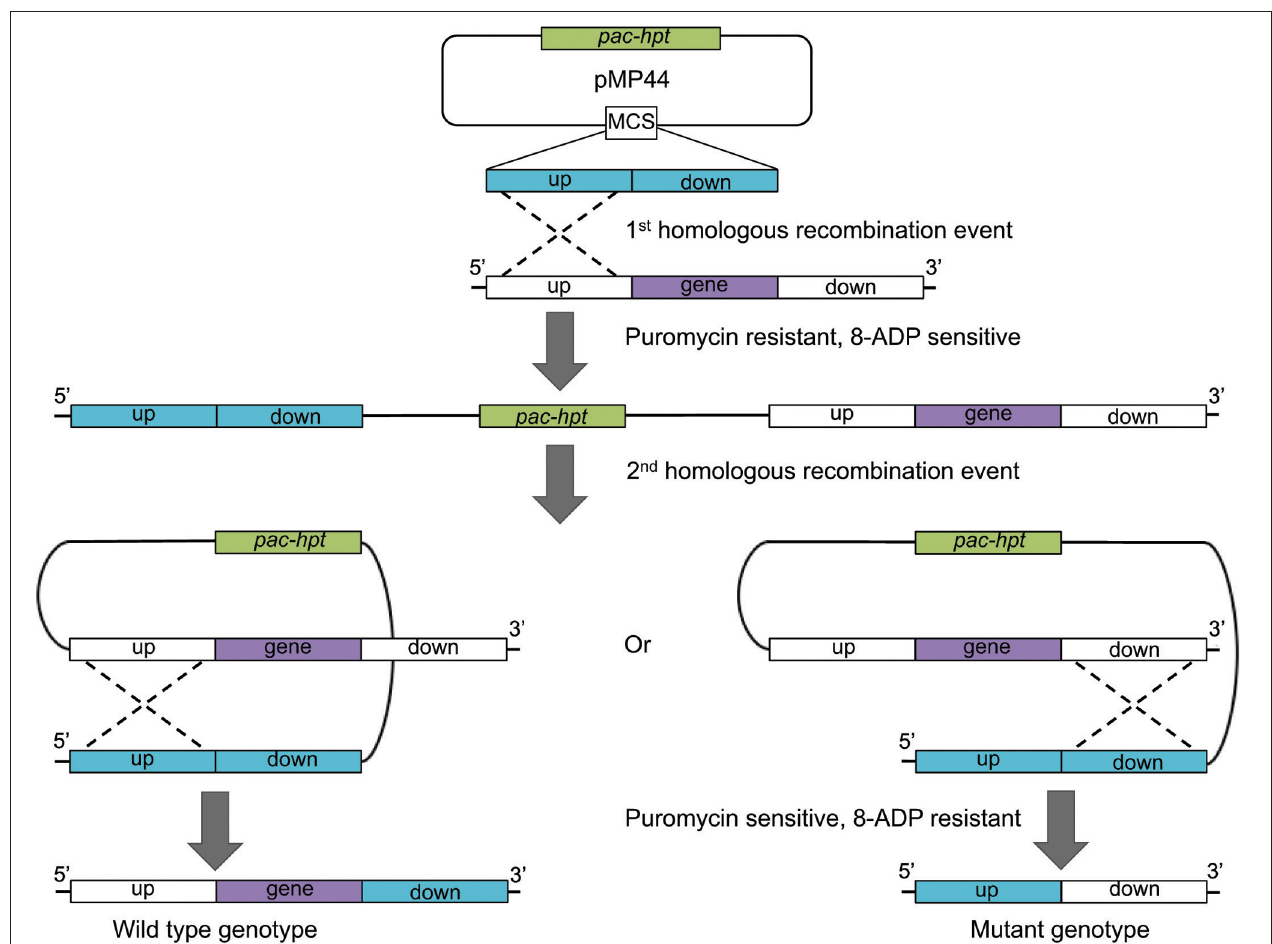
FIGURE 2 | Schematic of the construction of an unmarked deletion mutant strain using pMP44. Plasmid pMP44 carries a deletion construct comprising the homologous up- and downstream regions of the target gene. The circular plasmid is transformed into a Methanosarcina (cid:2) hpt strain. A homologousrecombination event (dotted line) creates a puromycin resistant